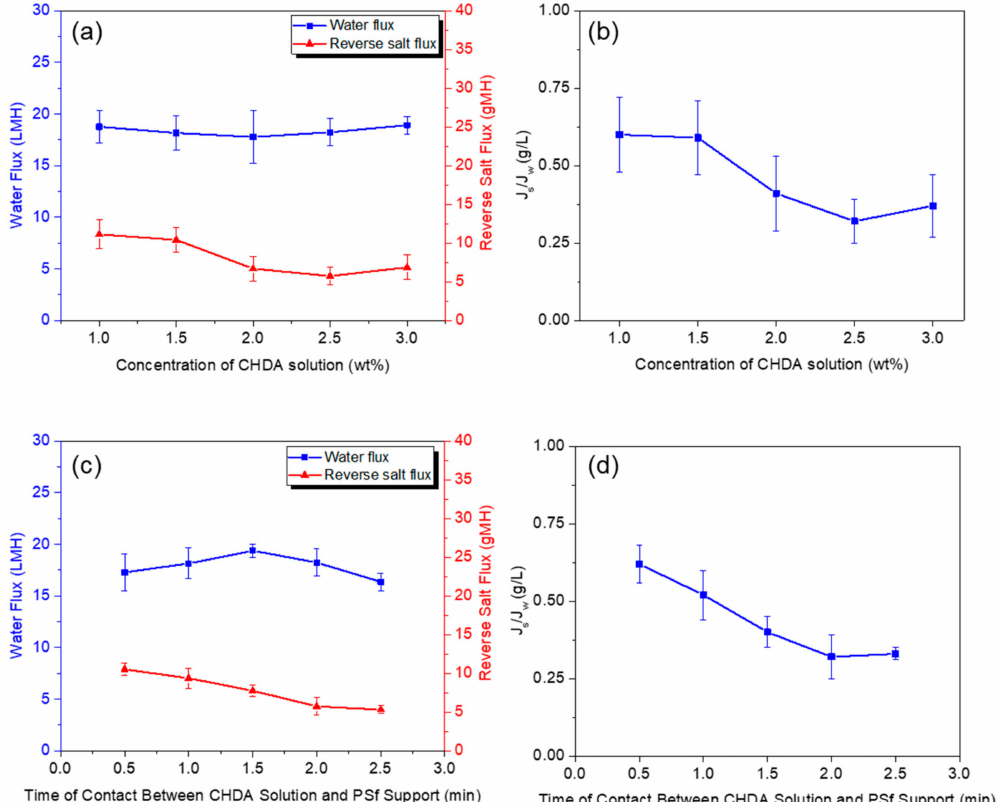
Figure 9 plots the effect of the following factors on the membrane performance: con- centration of aqueous CHDA solution and its time of contact with the PSf support. As the CHDA concentration increased, the water flux remained similar, about 19 LMH (Figure 9a). On the other hand, the reverse salt flux decreased when the CHDA concentration was more than 2 wt.%, a result supporting that the membrane became denser, thereby less salt solution passed through the membrane.